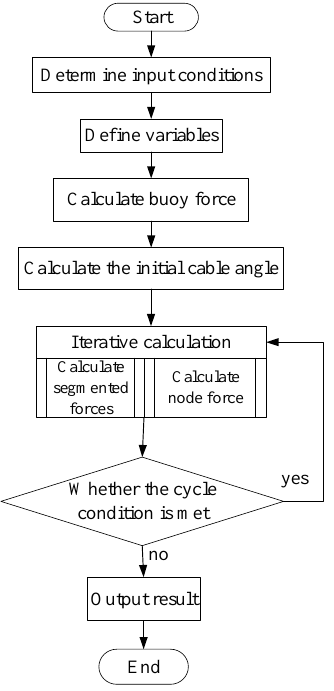
Figure 16. The iterative algorithm of mooring force calculation.